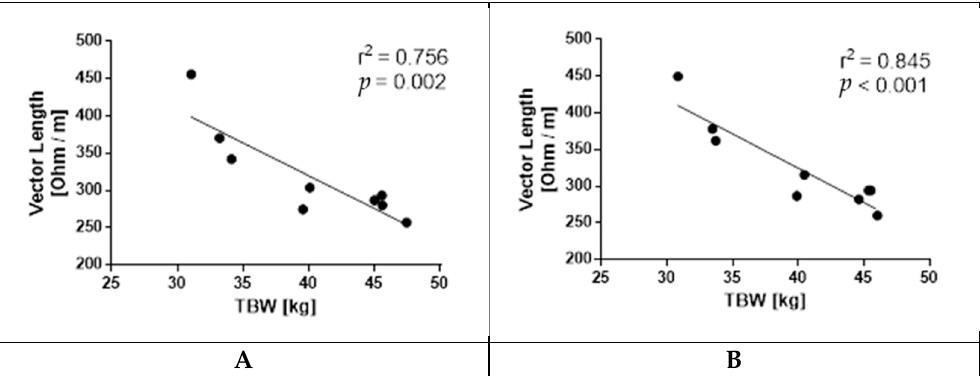
Figure 4. Correlation between total body water (TBW) and vector length. ( A ) Individual data points for deuterium dilution TBW measurements and BIVA measurements taken at the same time at NX. Linear regression: p = 0.002 and r 2 = 0.756. ( B ) Individual data points for deuterium dilution TBW measurements and BIVA measurements taken at the same time at HH. Linear regression: p < 0.001 and r 2 = 0.845.